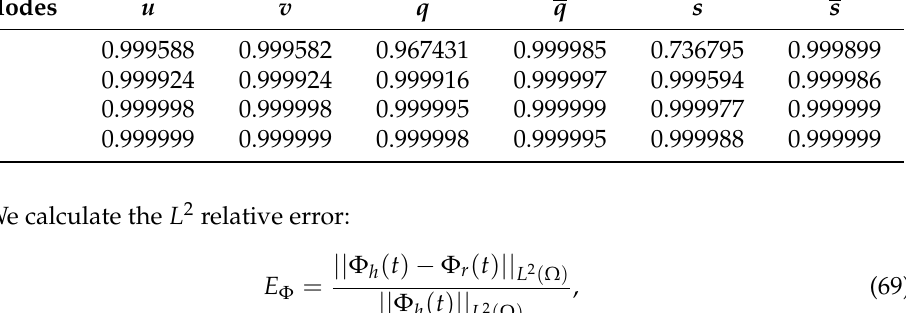
Table 1. First four cumulative eigenvalues for the velocity, pressure and supremizer fields. N